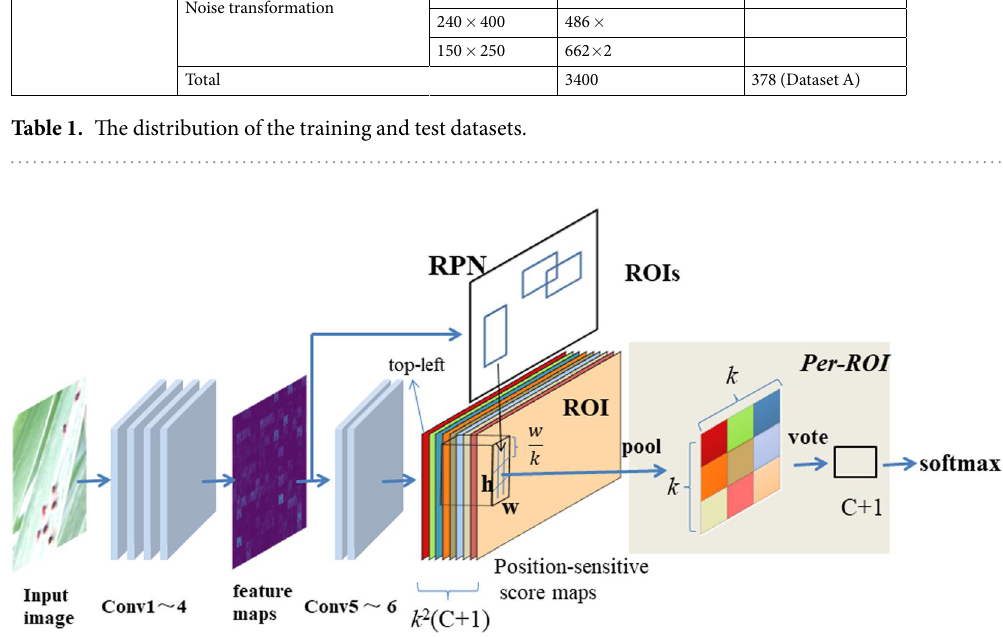
Figure 2. Flowchart of our deep learning-based method. The method consists of four convolutional layers (1~4) for extracting feature maps, two convolutional layers (5~6), a RPN containing k 2 ( C + 1) ROIs to detect position-sensitive score maps and make final results, as well a softmax layer to output classifications and